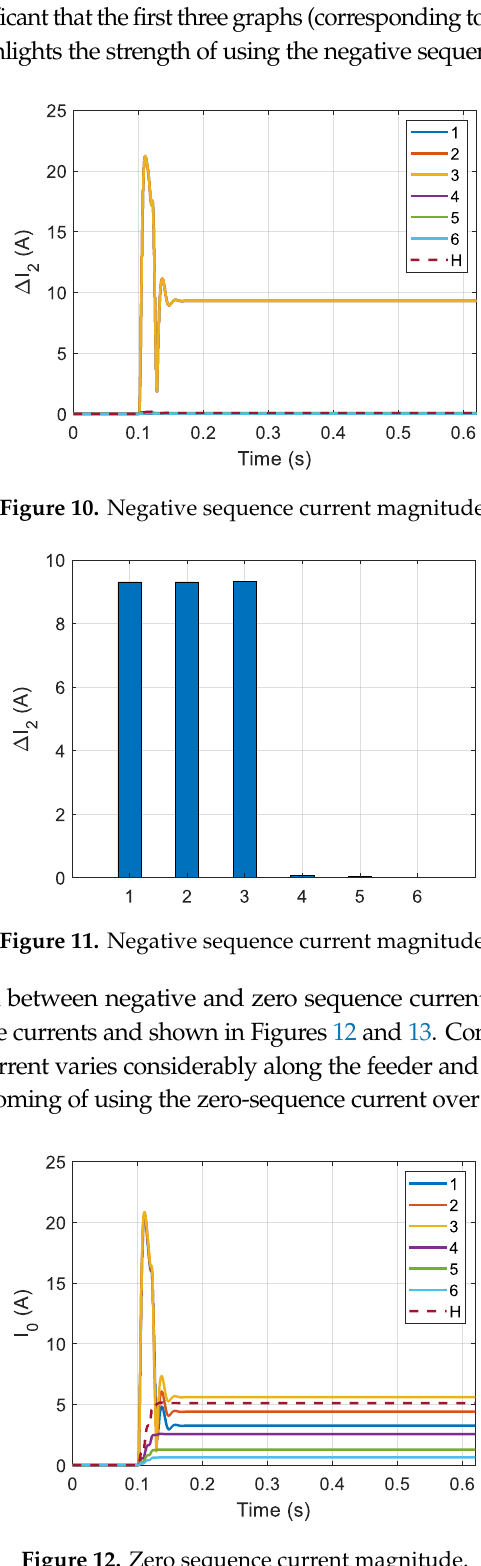
Figure 12. Zero sequence current magnitude.